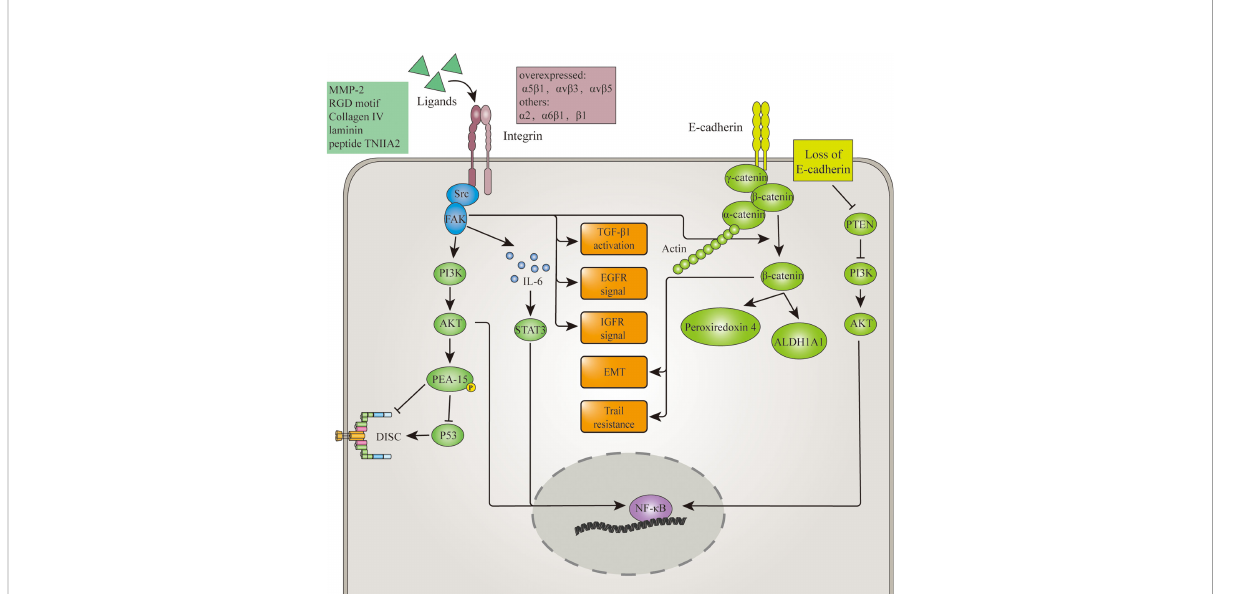
FIGURE 1 Adhesion molecules involved in anoikis resistance mechanism of glioma. Overexpression of Integrins and loss of E-cadherin in glioma disrupt the initiating signal of anoikis. Upon cell detachment, overexpressed integrins still activate FAK, which in turn activates signalings such as TGF b , EGFR, IGFR, PI3k/AKT pathway. Then through p53 inhibition, NF- k B activation or other mediators, these pathways lead to anoikis. a 2 integrin induced FAK activation also promotes the release of b -catenin from the E-cadherin/ b -catenin complex. Along with the loss of E-cadherin and the help of Wnt, this increased the cytoplasmic level of b -catenin. b -catenin thereby promote anoikis resistance through EMT, TRAIL resistance and upregulation of invasion-related protein ALDH1A1 and peroxiredoxin 4. Aside from b -catenin, loss of E-cadherin also downregulates tumor suppressor PTEN and therefore maintains NF- k B